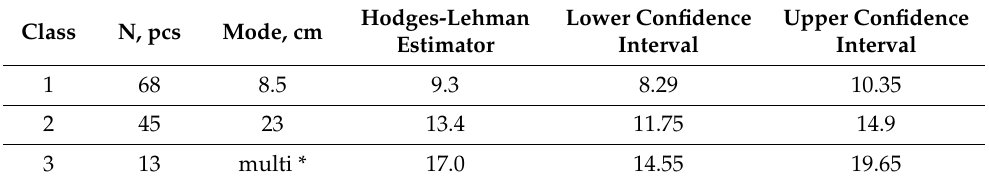
Table 8. The volume of classes of the spatial structure factor and the amplitude of indicators of DBH in them. Class N, pcs Mode, cm